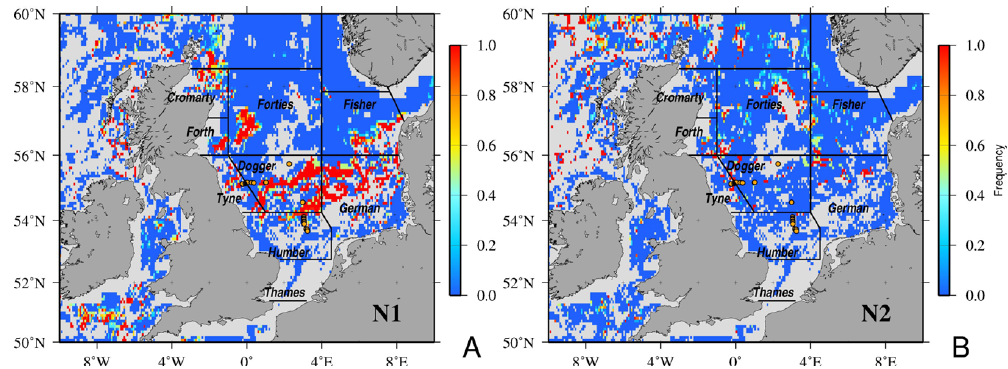
Figure 12. (a, b) Frequency of occurrence of the two distinct anomalies (N1 and N2) over the North Sea during the sampling period (08 to 12 May 2011). Yellow squares correspond to MODIS matching points for non-turbid waters selected between 06:00 and 18:00 and used to distinguish N1 and N2 PHYSAT